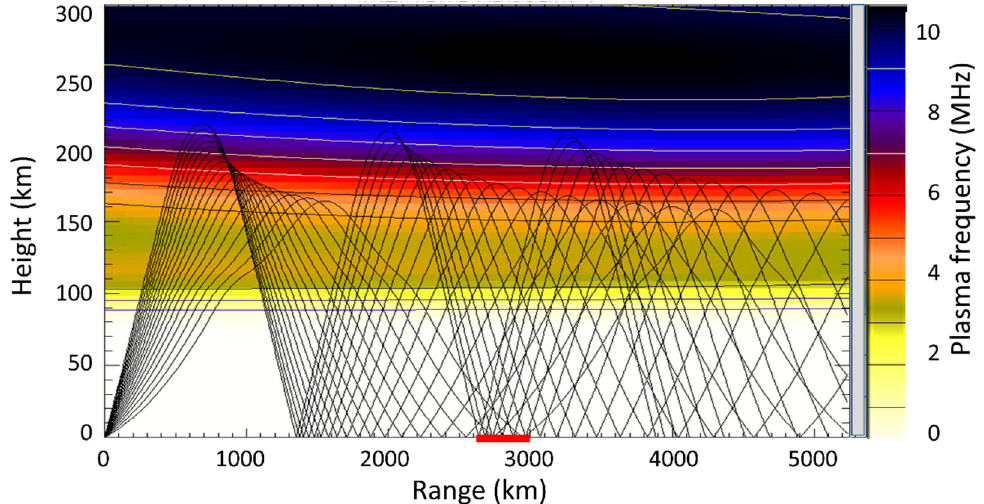
Figure 5. Ray-tracing through a model ionosphere, showing the zone (marked in red on the abscissa) where 1-hop and 2-hop illumination overlap. At the frequency used here, no reflection from any lower layer—sporadic E appearing near 100 km altitude—occurs, nor does ducted propagation between the E s and F